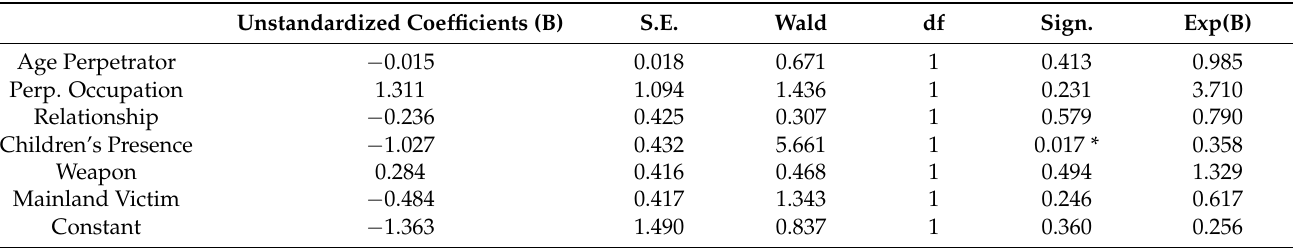
Table 5. Logistic regression model predicting the violence maltreatment before the COVID-19 lockdown. Unstandardized Coefficients (B)